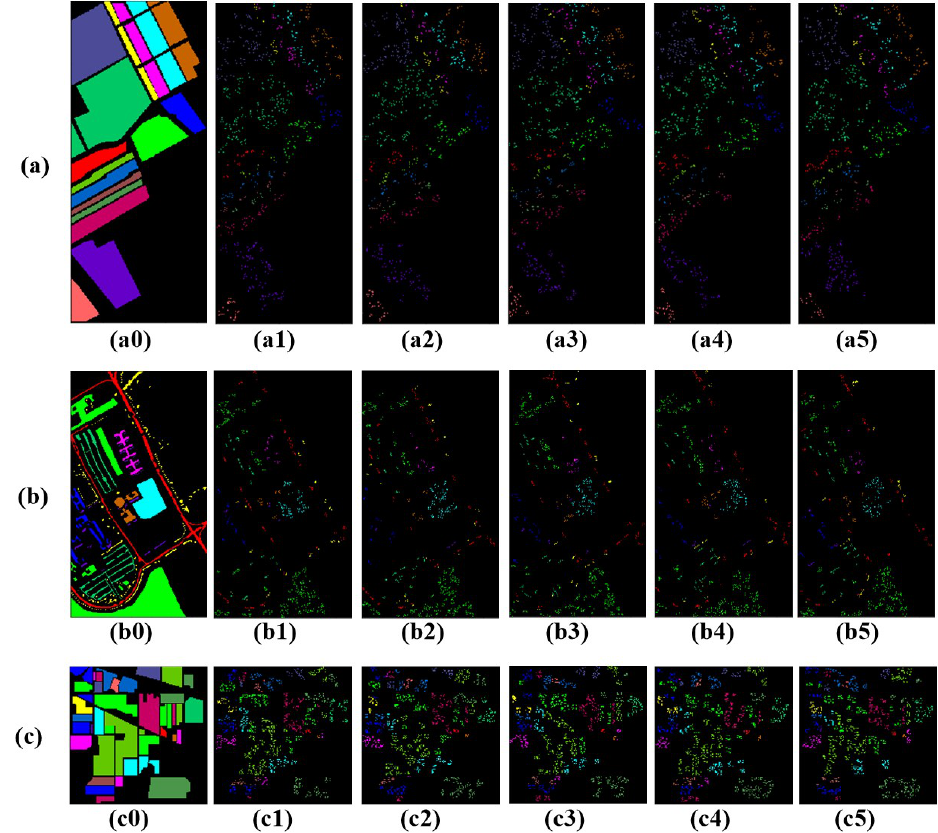
Figure 6. Training pixels in ( a ) Salinas Valley dataset, ( b ) Pavia University dataset, and ( c ) Indian Pines dataset. Here the sub-Figure 0 in each dataset is the corresponding ground truth for the dataset, and other sub-figures represent the training pixels for 5-round hold-out